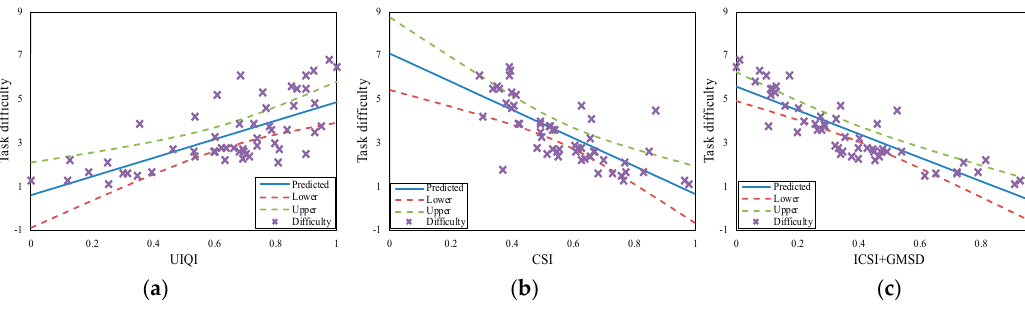
Figure 5. The correlations of the ( a ) CSI, ( b ) UIQI and ( c ) ICSI + GMSD for task difficulty.